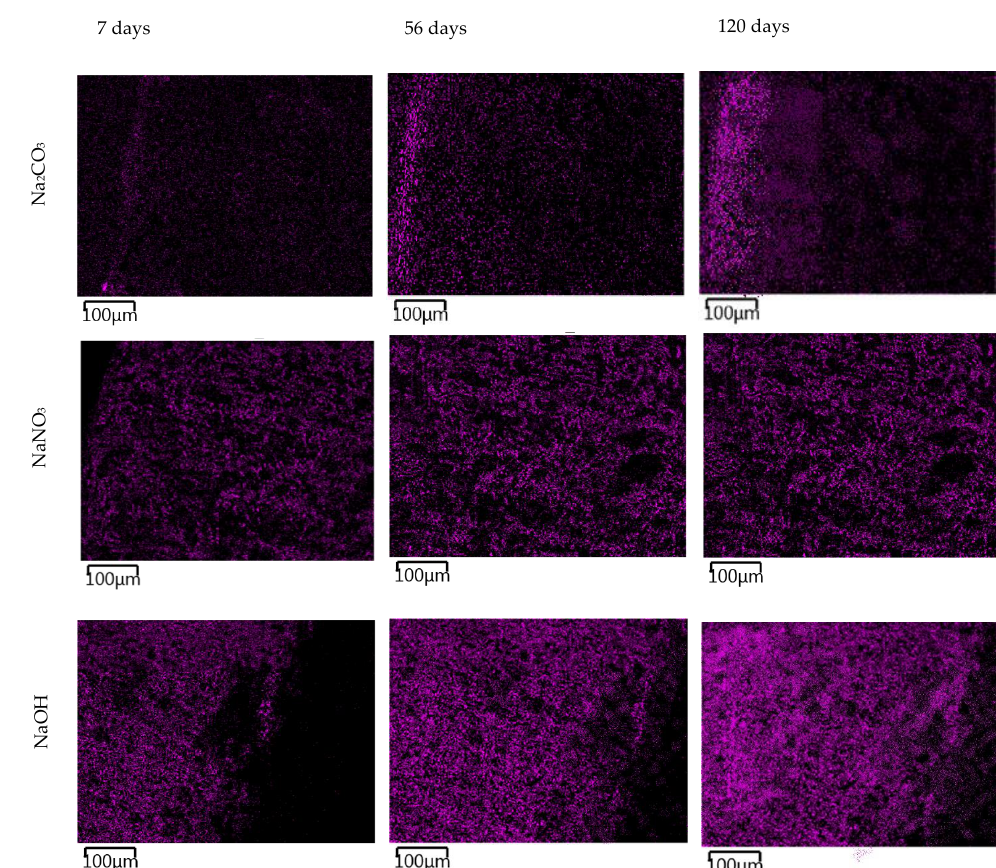
Figure 11. EDX mapping of sodium ion permeation in a 1 mol/L solution at 40 °C over time. The magenta color represents sodium in the EDX mapping images.